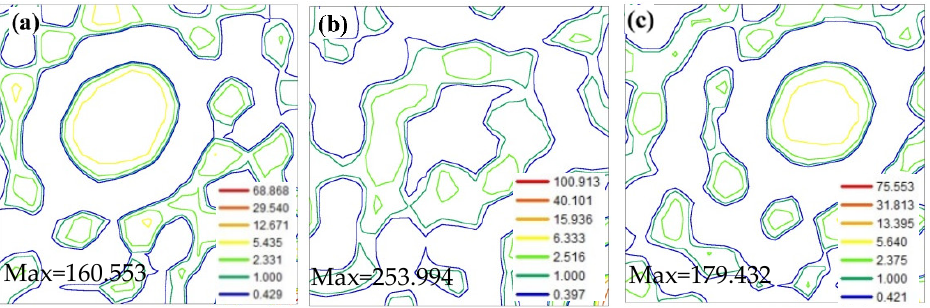
Figure 6. ODF sections ( ϕ 2 = 45 ◦ ) of finally annealed samples in different atmospheres: ( a ) 100%H 2 ; ( b ) 25%H 2 + 75%N 2 ; ( c ) 50%N 2 + 50%H 2 .